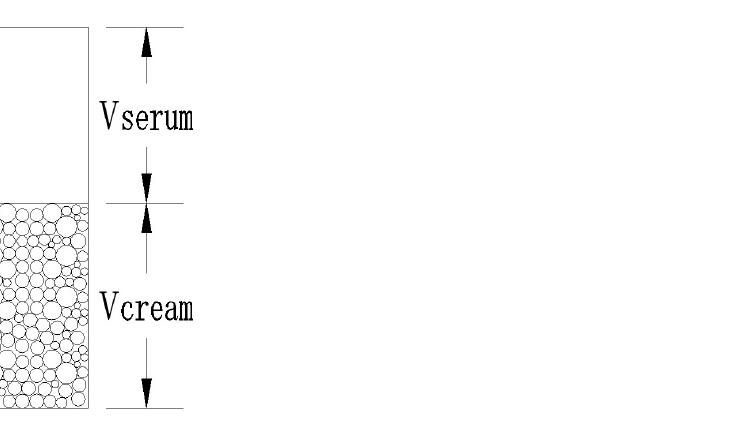
Figure 1. Schematic representation of EI. Vserum: volume of clear liquid after homogenization; Vcream: volume of the emulsified layer after homogenization; Vtotal: volume of total emulsion.